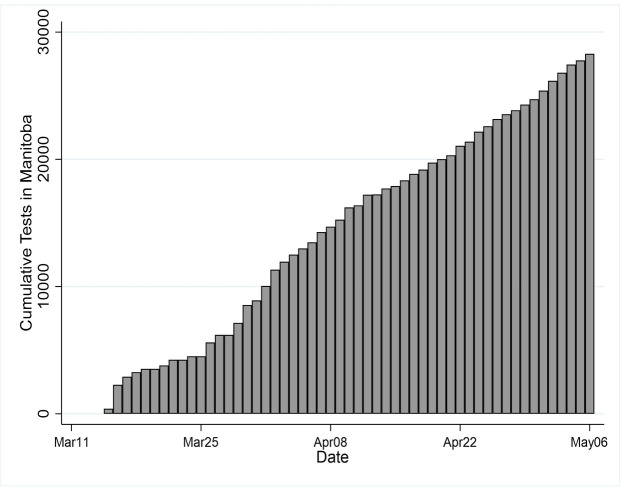
Cumulative COVID-19 tests by day in Manitoba.